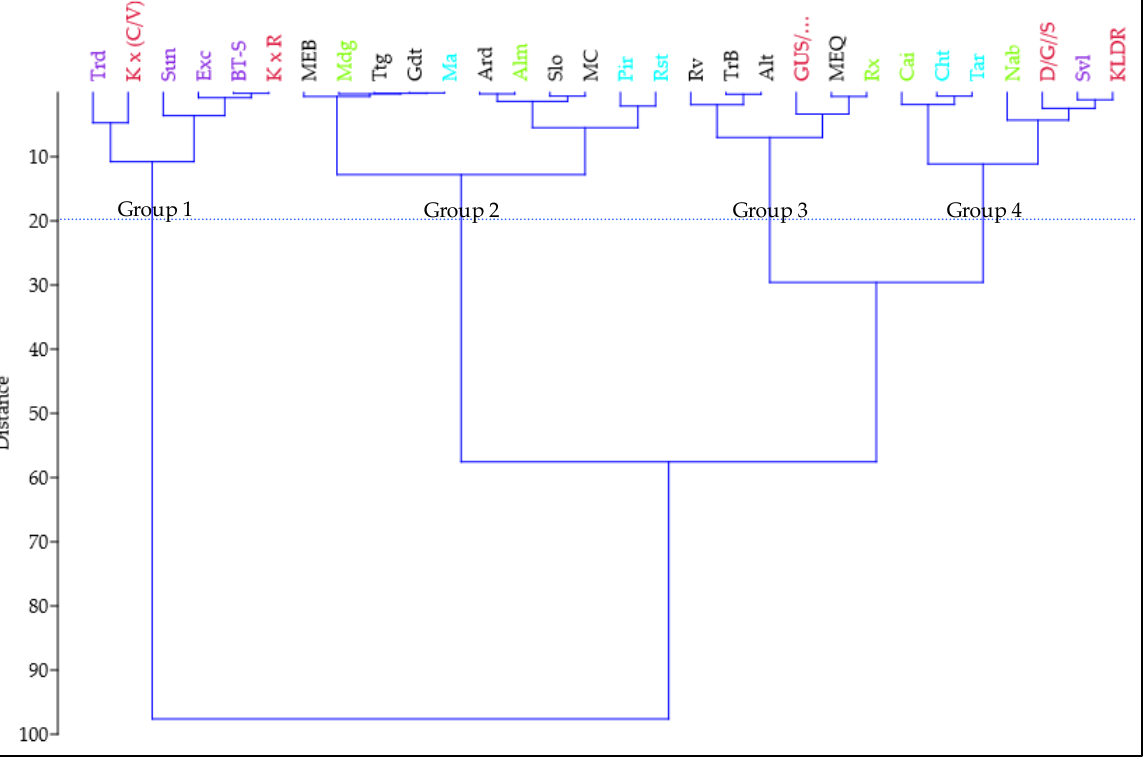
Figure 2. Dendrogram of hierarchical clustering using Ward’s method of 30 genotypes of T. aestivum L. based on the root growth angle at seedling stage. The horizontal line indicates the cut-off used to form the groups. Portuguese landraces (in black); Italians (in blue); Green Revolution (in green); Australians (in purple); Advanced Lines (in red).